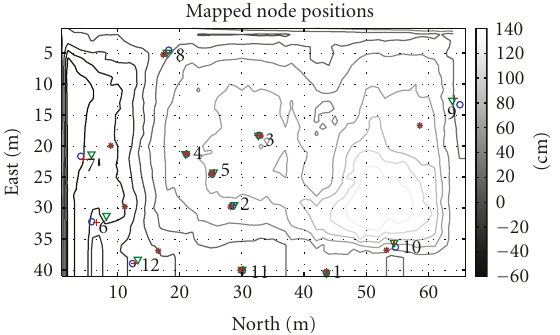
Figure 21: Mapped node positions with respect to actual surveyed positions using anchor nodes 1, 2, and 3. Circles are actual surveyed positions, crosses are positions resolved with complete set of pair- wise distance, triangle are resolved with 10% largest distance miss- ing, while asterisks are resolved with 20% largest distance